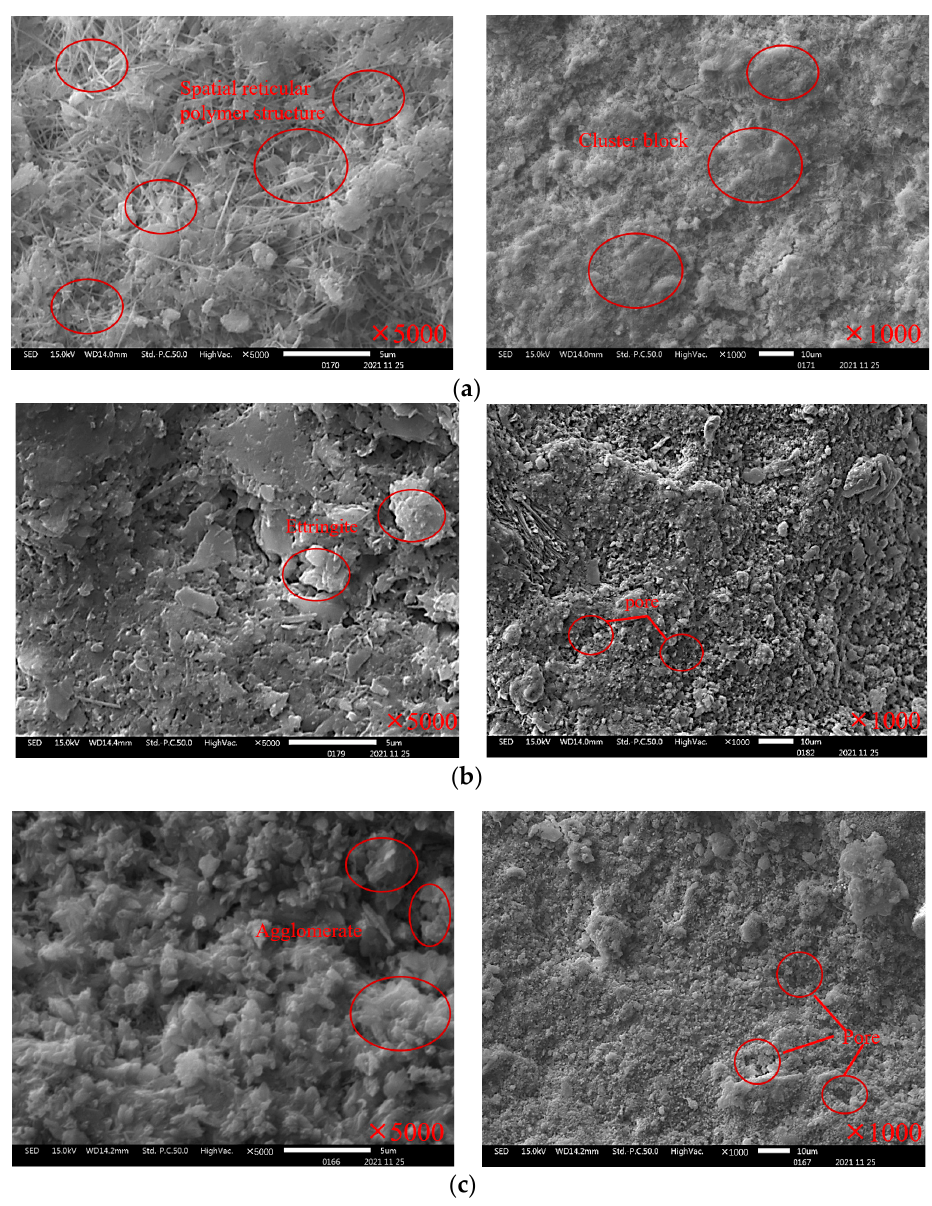
Figure 20. SEM results of test columns. ( a ) HPCG. ( b ) RPCG. ( c ) MKCG.